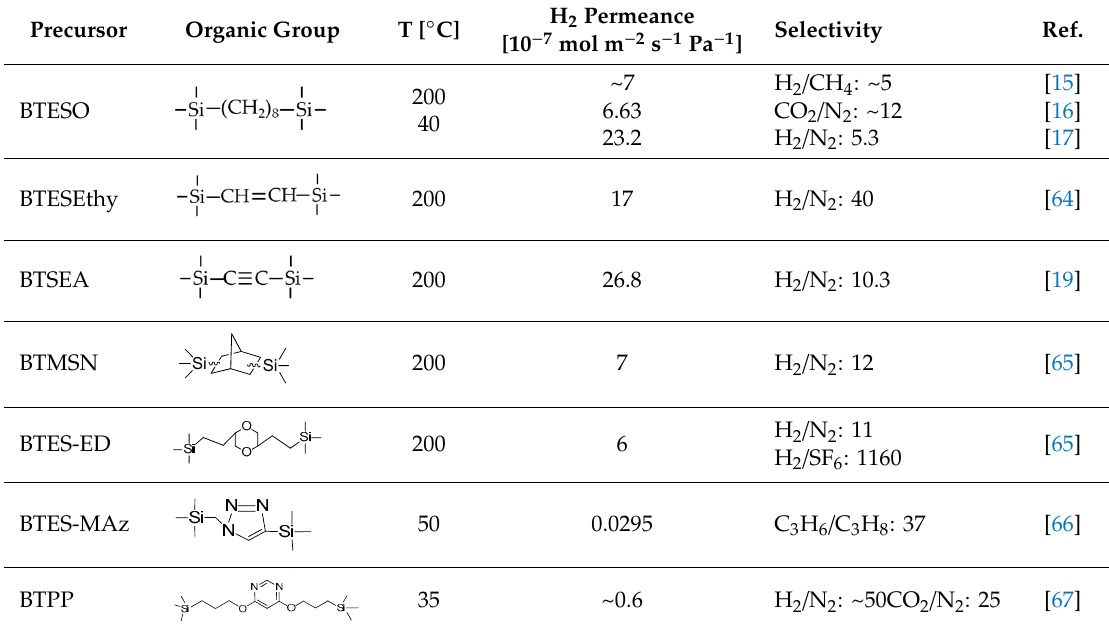
Table 3. Bridged-organosilica membranes and their performance in liquid-phase separation.